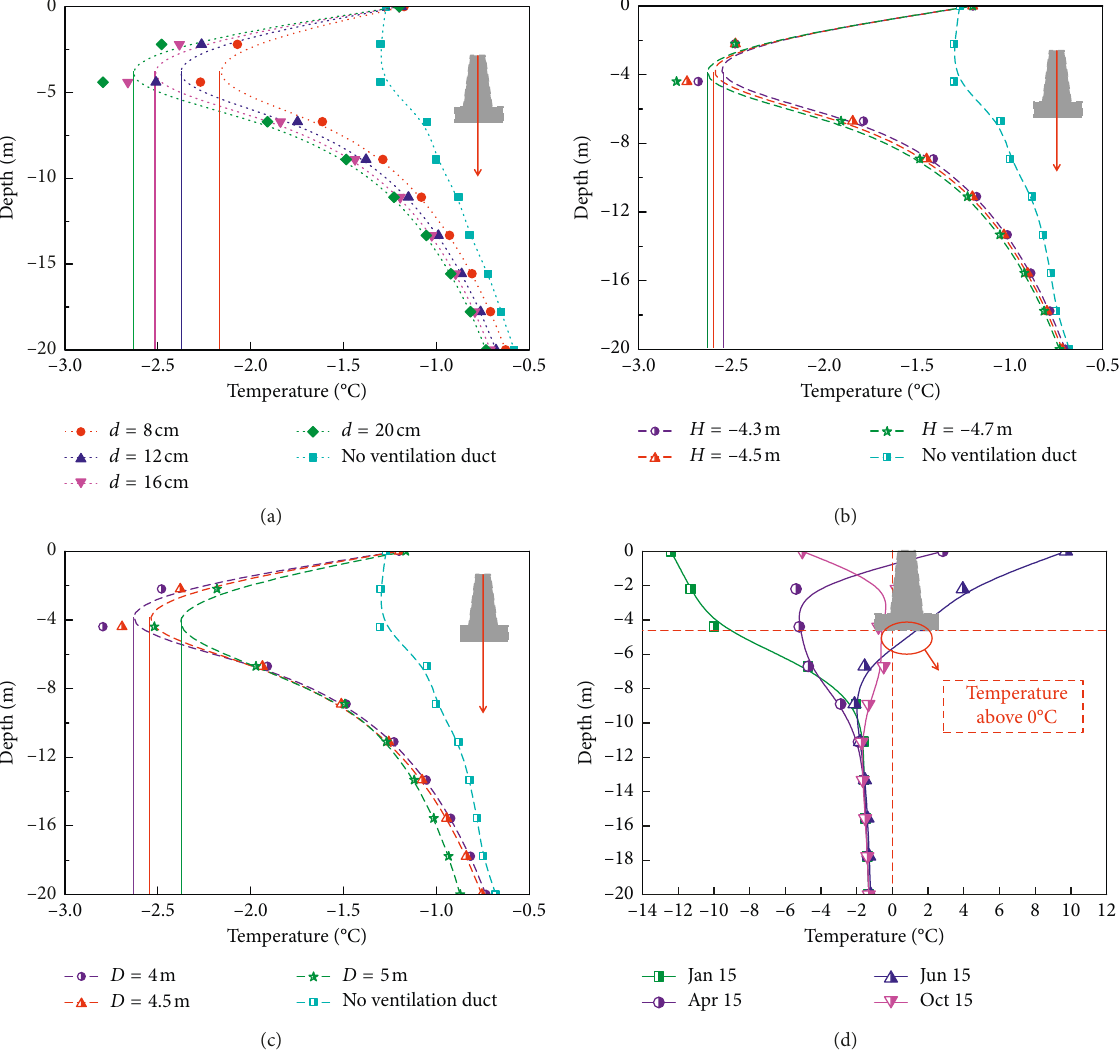
Figure 14: Temperature distribution along the footing centreline. (a) Effect of the ventilation duct diameters on the annual mean temperature. (b) Effect of the ventilation duct buried depths on the annual mean temperature. (c) Effect of the ventilated-duct tower foundation diameters on the annual mean temperature. (d) Season-dependent temperature